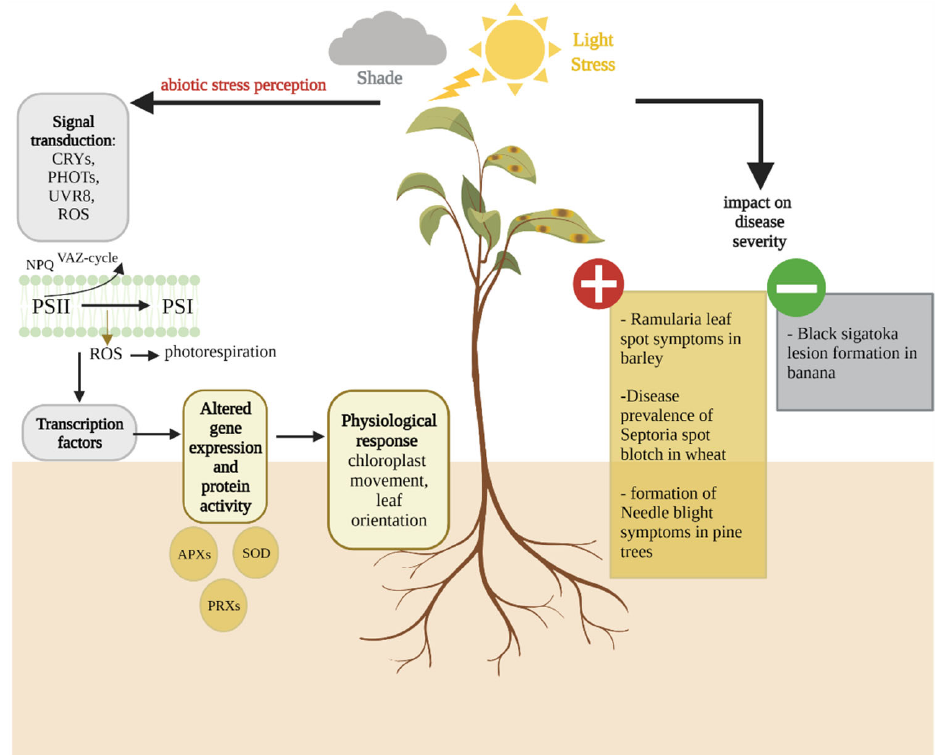
Figure 4. Overview of the host light stress response and its impact on Dothideomycete-induced disease severity. Figure 4 highlights the signalling pathway involved in the light stress response in the host (left) and the effect of high light (orange) and shade (grey) stresses on Dothideomycete ‐ induced disease severity (right). Light intensity is perceived by UV ‐ A/B photoreceptors, such as cryptochromes (CRYs), phototropins (PHOTs) and the UV RESISTANCE LOCUS 8 (UVR8). Excess light leads to photoinhibition of the photosystem II (PSII), resulting in the production of reactive oxygen species (ROS) in the chloroplasts. To prevent photoinhibition ‐ associated damage, photoprotection mechanisms include cyclic electron flow (CEF), the xanthophyll cycle (violaxanthin-antheraxanthin-zeaxanthin cycle, VAZ), the photorespiratory pathway and ROS scavenging enzymes, such as ascorbate peroxidases (APXs), peroxiredoxins (PRXs) and superoxide dismutase (SOD). In response to high light, chloroplasts move away from the cell surface to reduce light absorption in a process known as chloroplast avoidance. In contrast, under low light conditions, chloroplasts accumulate near the cell surface.